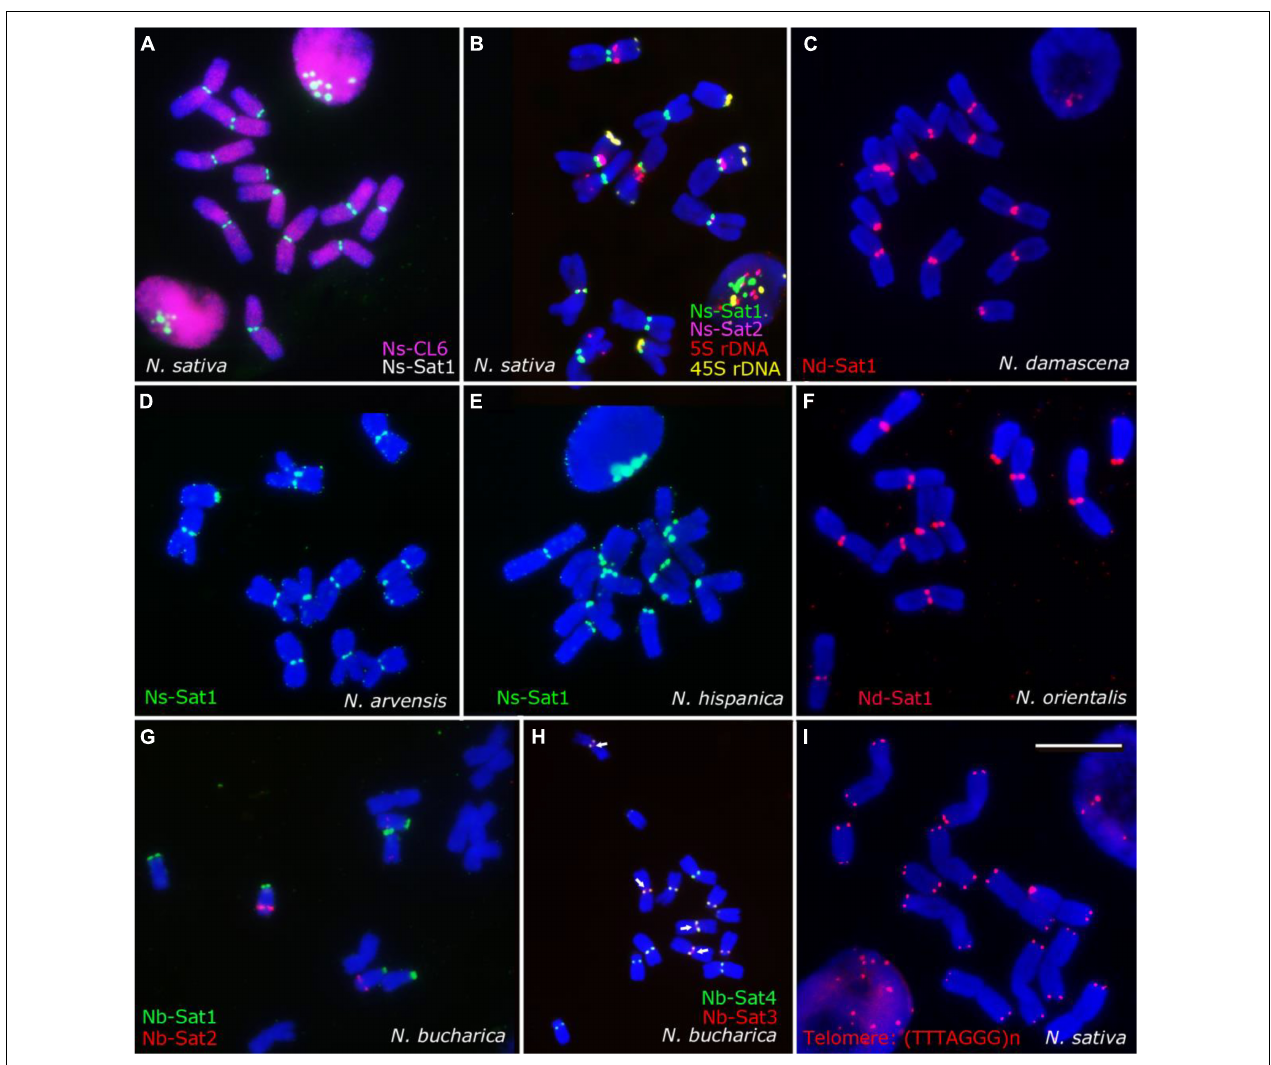
FIGURE 4 | Chromosomal distribution of the identified high-copy repeats of Nigella. FISH results using the identified satellite repeats and Arabidopsis-type telomeric repeat probe (TTTAGGG)n probes on mitotic metaphase chromosomes of N. sativa (A,B,I) , N. damascena (C) , N. arvensis (D) , N. hispanica (E) , N. orientalis (F) and N. bucharica (G,H) . The Ns-CL6 (red) repetitive sequence is dispersed throughout the genome (A) , while the satellite sequences are mostly (peri)centromeric. Scale bar 10 µ m.